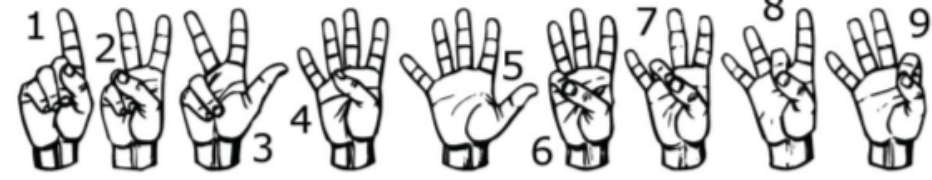
Figure 3. Performed ASL numbers from 1 to 9